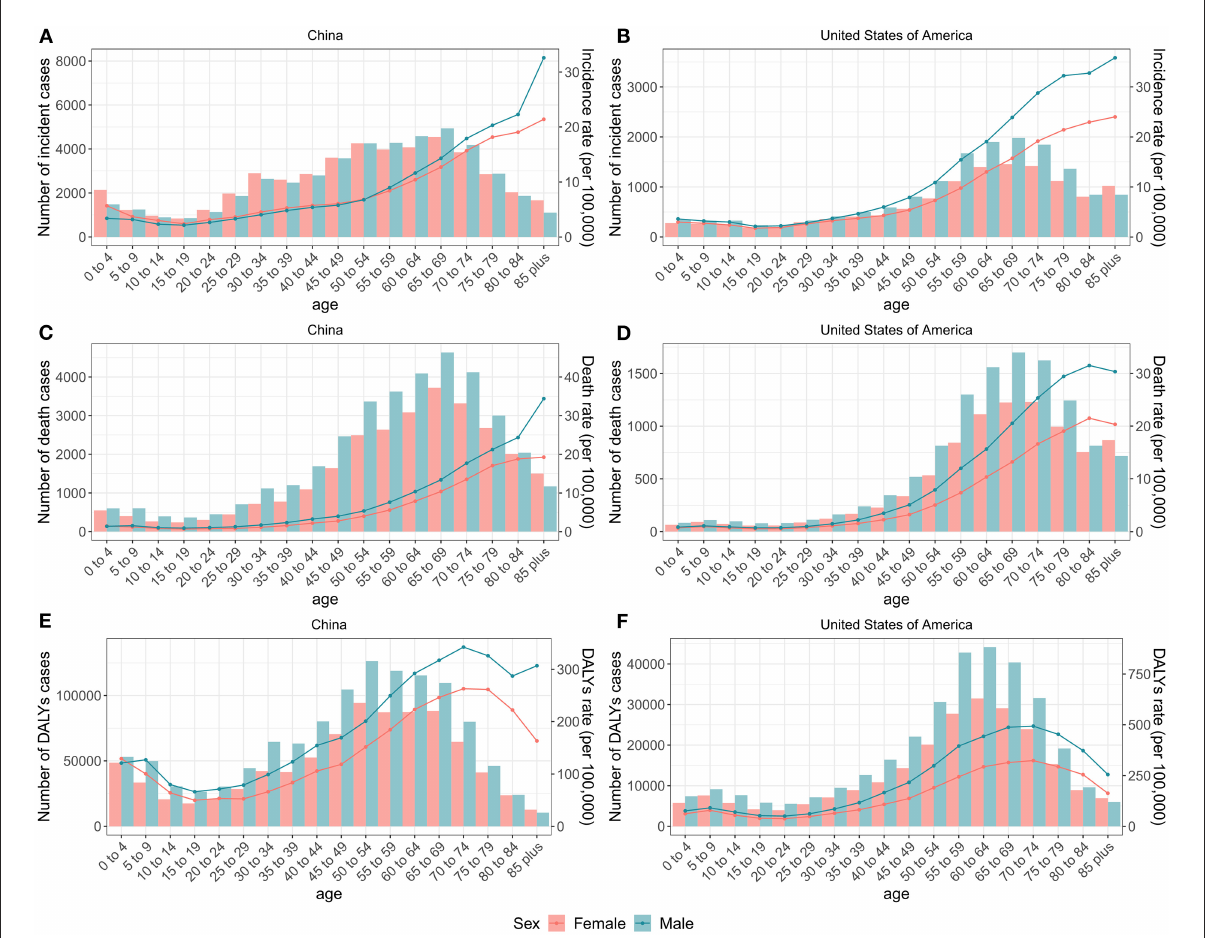
FIGURE2 Numbers and rates of incidence, death, and DALYs of brain and CNS cancers for each age group by sex in China and the US, 2019. The number and rate of incidence of brain and CNS cancers for each age group by sex in China (A) and the US (B) . The number and rate of deaths of brain and CNS cancers for each age group by sex in China (C) and the US (D) . The number and rate of DALYs of brain and CNS cancers for each age group by sex in China (E) and the US (F) . Lines indicate rate and bars indicate absolute number. DALYs, disability-adjusted life-years; CNS, central nervous